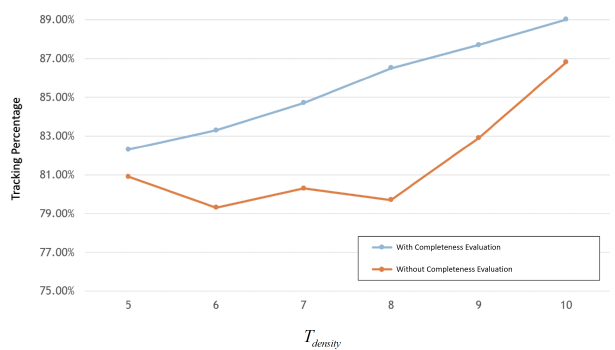
Figure 15. Localization performance with/without completeness